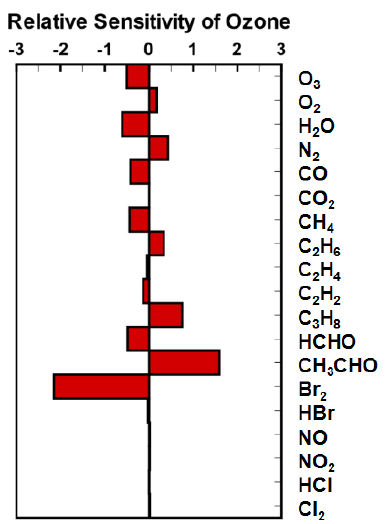
Figure 6. Relative concentration sensitivities of ozone under an initial NO